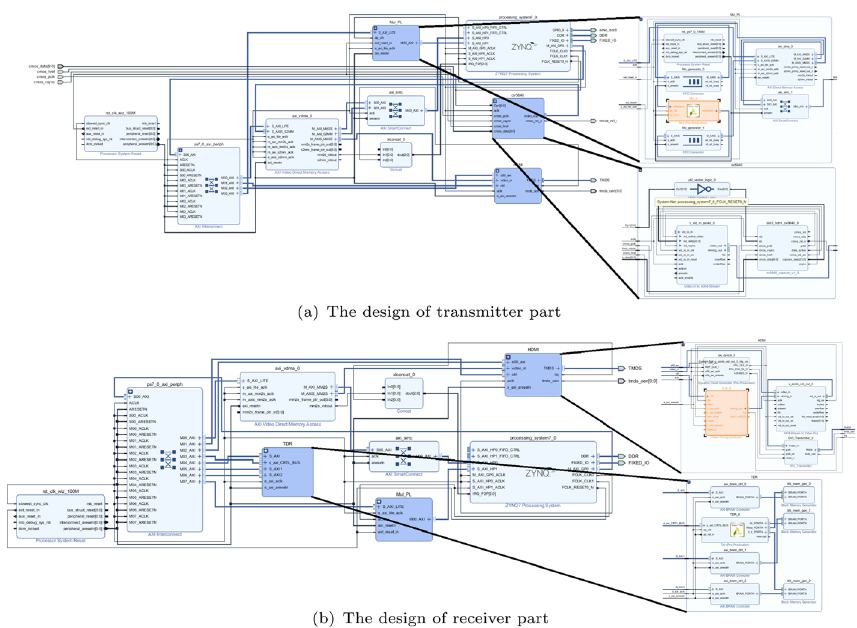
Fig. 9 The electronic design of the CSTDR-based secure communication scheme using ZYNQ 7020